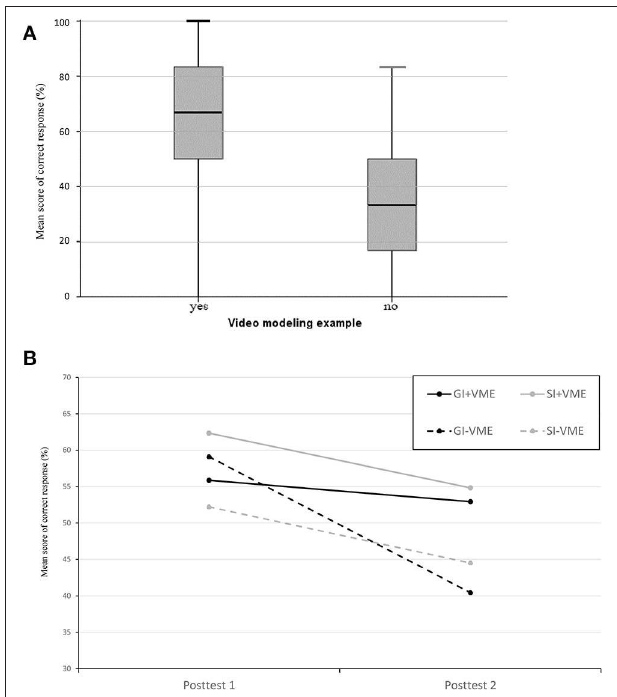
FIGURE 2 | (A) Mean score of correct responses by treatment 1 (video modeling example vs. no video modeling example) in percentage. (B) Mean score of correct responses by treatments and time in